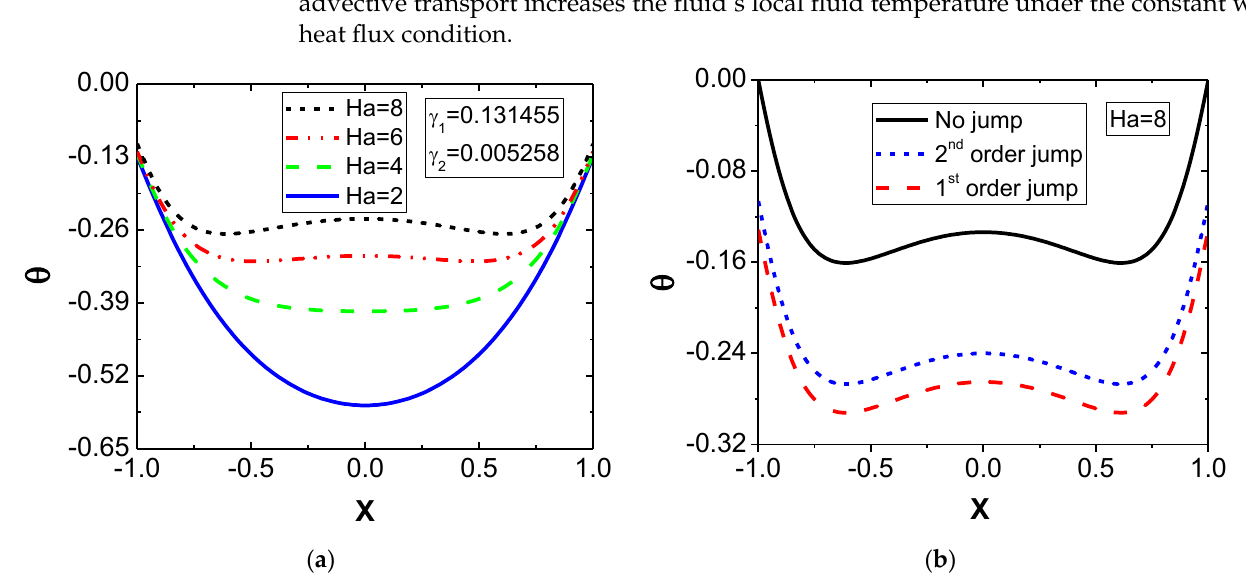
( a ) Second-order jump; ( b ) Comparison of no-jump, first-order jump, and second-order jump at Ha = 1.0.